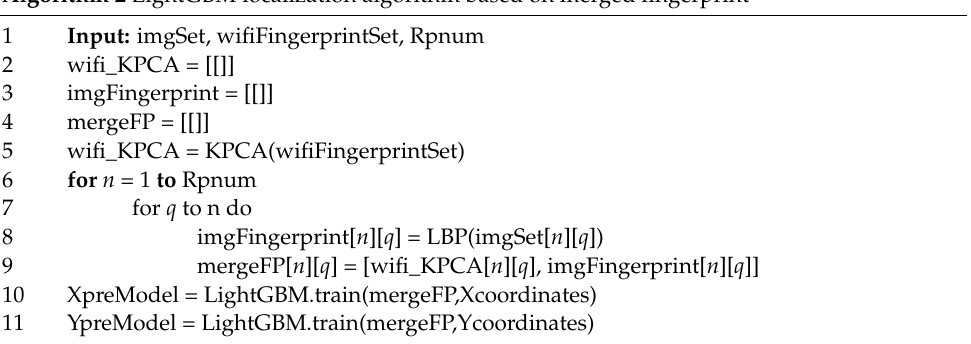
Algorithm 2 LightGBM localization algorithm based on merged fingerprint